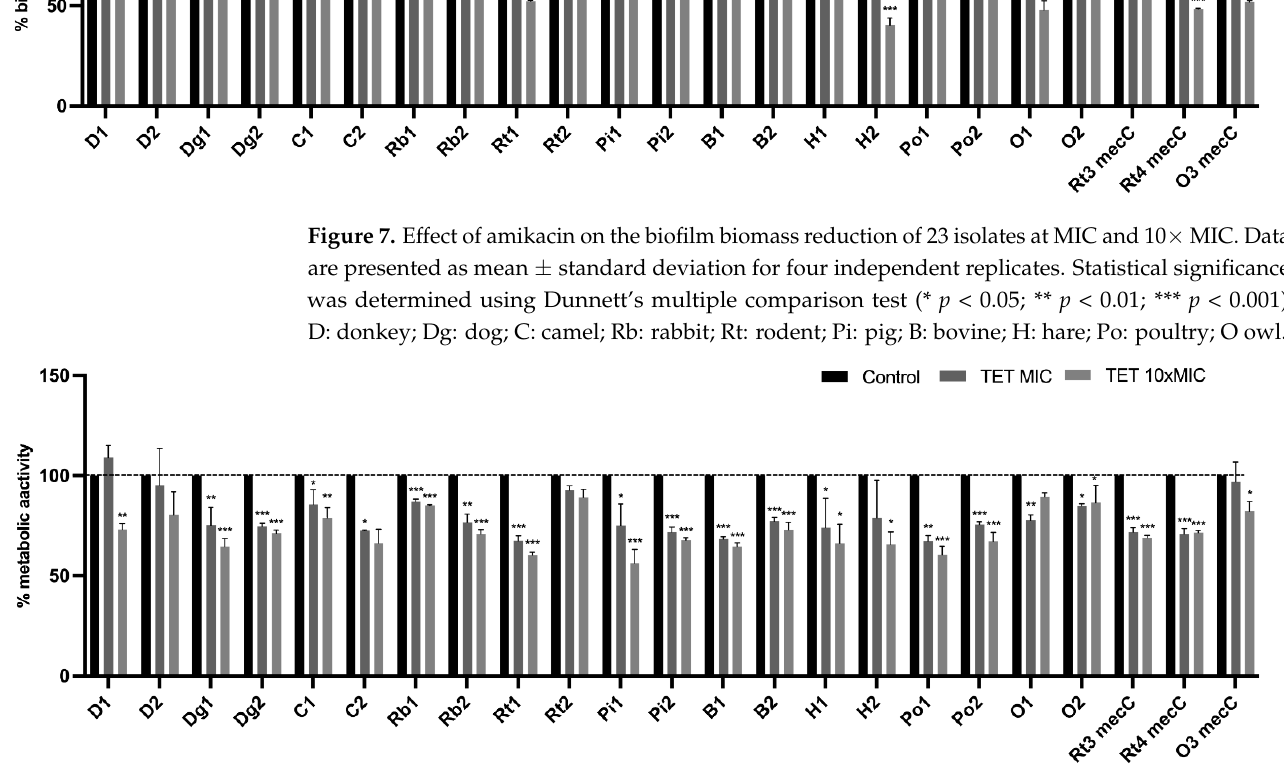
Figure 8. Metabolic activity of S. aureus biofilms before and after treated with tetracycline at concen- trations of MIC and 10× MIC. The results are expressed as percentage of metabolic activity. Statisti- cal significance was determined using Dunnett ’ s multiple comparison test (* p < 0.05; ** p < 0.01; *** p < 0.001). D: donkey; Dg: dog; C: camel; Rb: rabbit; Rt: rodent; Pi: pig; B: bovine; H: hare; Po: poultry; O